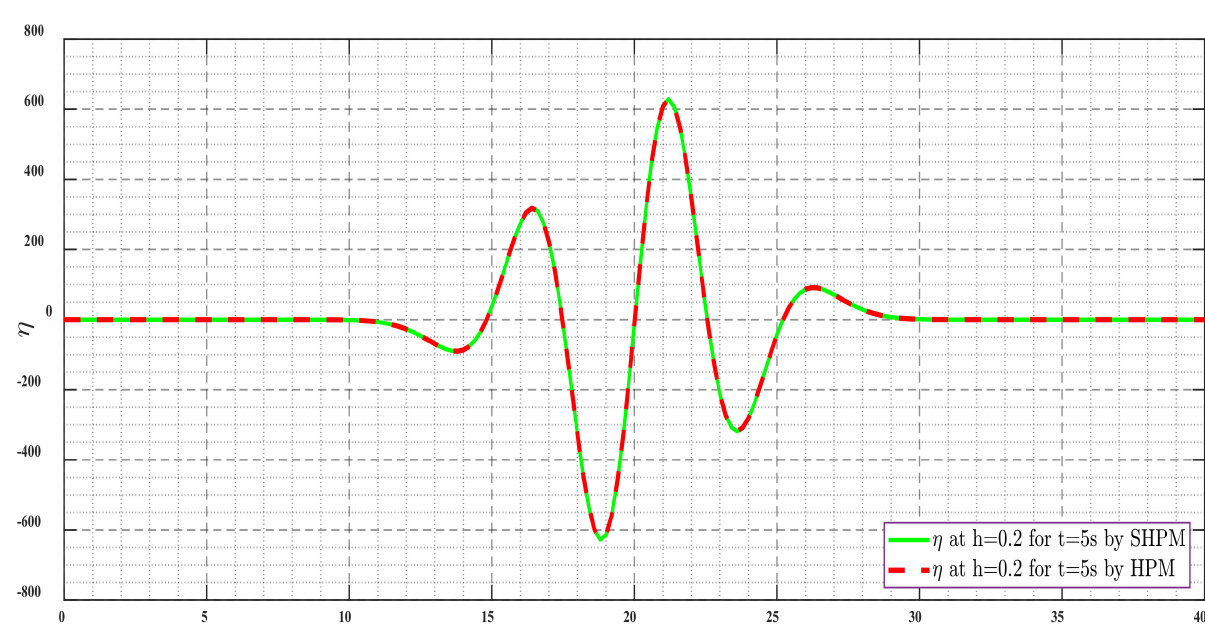
Figure 11. WSE ( η ) by SHPM and HPM at t = 5 s ( h = 2.0 ).